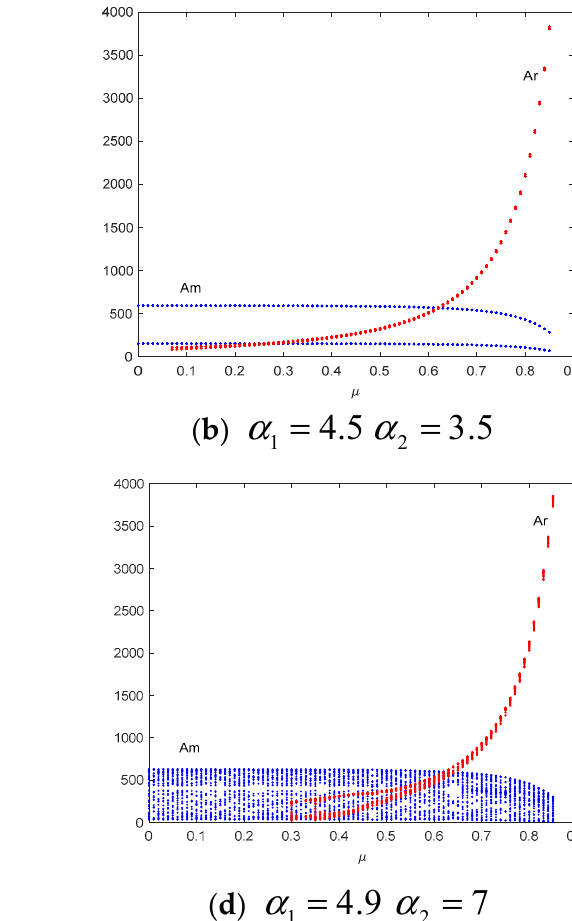
Figure 9. The Bifurcation diagram of A m and A r with respect to µ with different α 1 and α 2 .